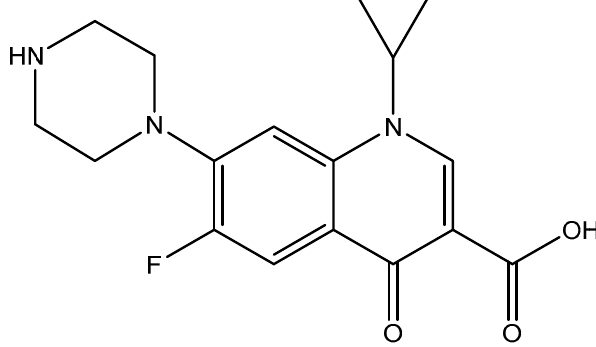
Figure 1. Chemical structure Cirofloxacin (CFX).